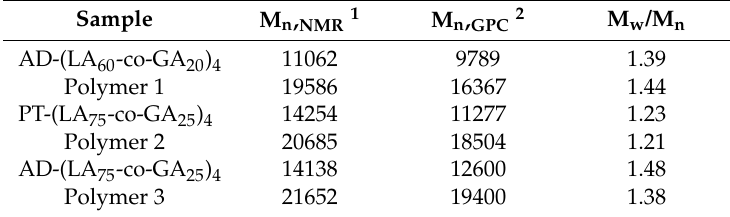
Figure 1. 1 H NMR spectrum of polymer 3 in CDCl 3 . Table 1. Molecular weight and particle size and polydispersity (PDI) of the polymers.